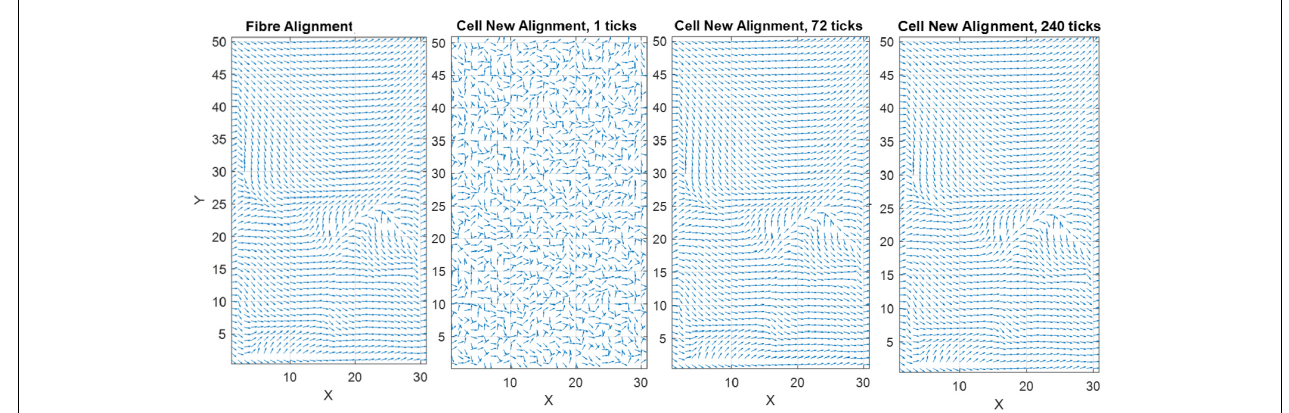
FIGURE 7 | Quiver plot demonstrating the change in orientation of cells, in response to the influence of fibers alone, predicted by the model (pre-calibration to experimental data) without the inclusion of apoptosis or